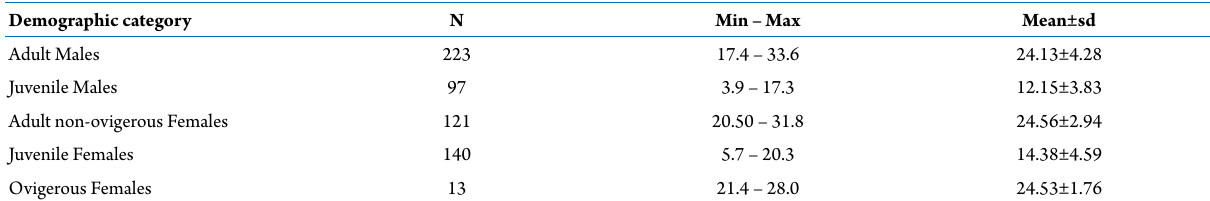
Figure 2. Regression between carapace width and major cheliped propodus of males ( A ), and carapace width and abdomen width for females of Uca maracoani ( B ). In ( A ), light gray circles represent juveniles and black circles represent adults. In ( B ), light gray circles represent juvenile females, gray circles represent transitional phase, and black circles represent adult females. Table 3. Abundance and range (minimum and maximum) and mean carapace width (CW in mm) (± standard deviation) of Uca maracoani by demographic category. N = number of